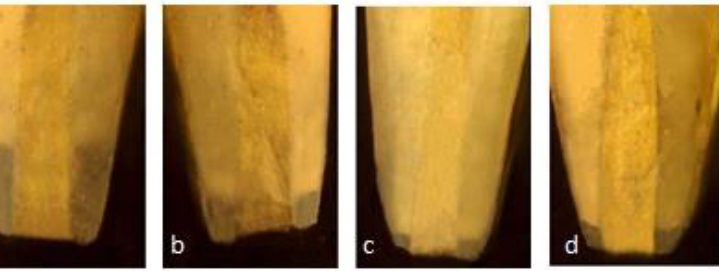
Figure 2. Stereomicroscopic images of Leakage in different group at 1 Month ( a ) GIC (1.35 mm) ( b ) Pro Root MTA (0.53 mm) ( c ) Neo MTA plus (0.08 mm) ( d ) Biodentine (0.13 mm).